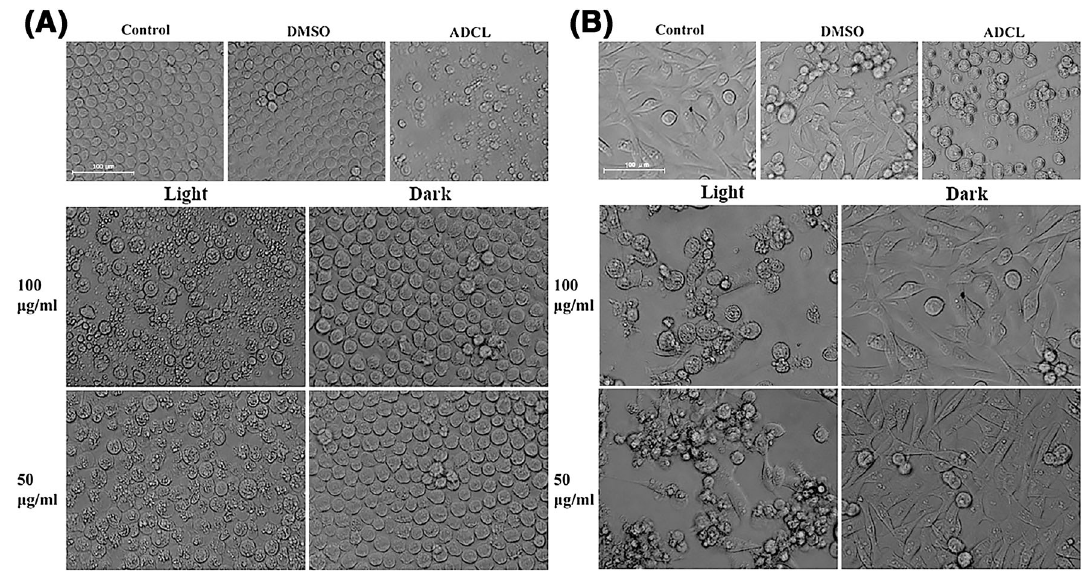
Fig. 1 Morphological changes in U937 and SK-HEP-1 cells treated with BNCE and light. Cells were treated with BNCE 50 and 100 l g/ ml concentrations and then irradiated at 3250 Lux for 10 min with daylight fluorescent lamps (wavelengths: 440, 550, and 620 nm) or kept in the dark. After 6 h, cells were visualized under an inverted